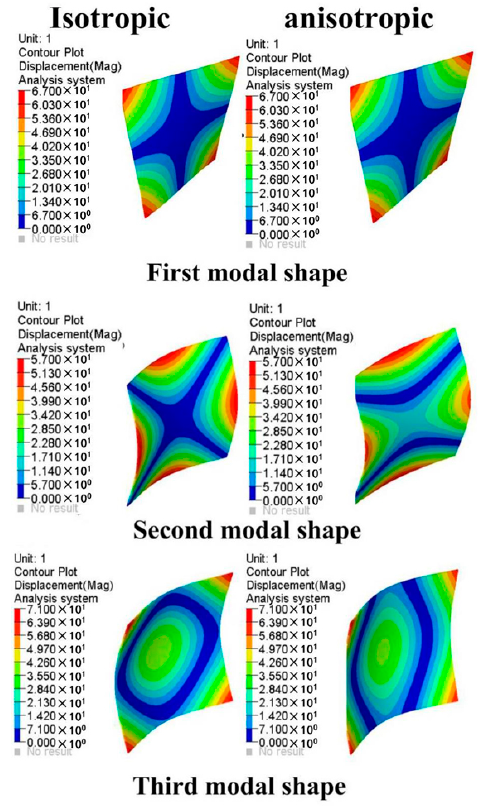
Table 2. Comparisons of free modal frequencies between the isotropic and the anisotropic plates.